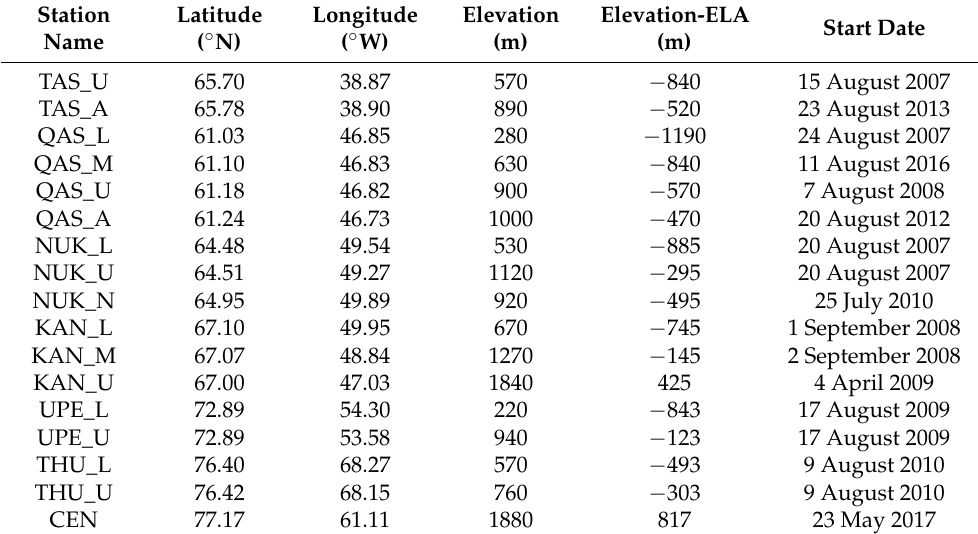
* L: Lower station, M: Middle station, U: Upper station.